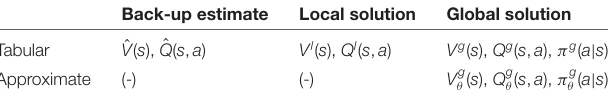
TABLE 3 | Overview of notation. Back-up estimate Local solution Global